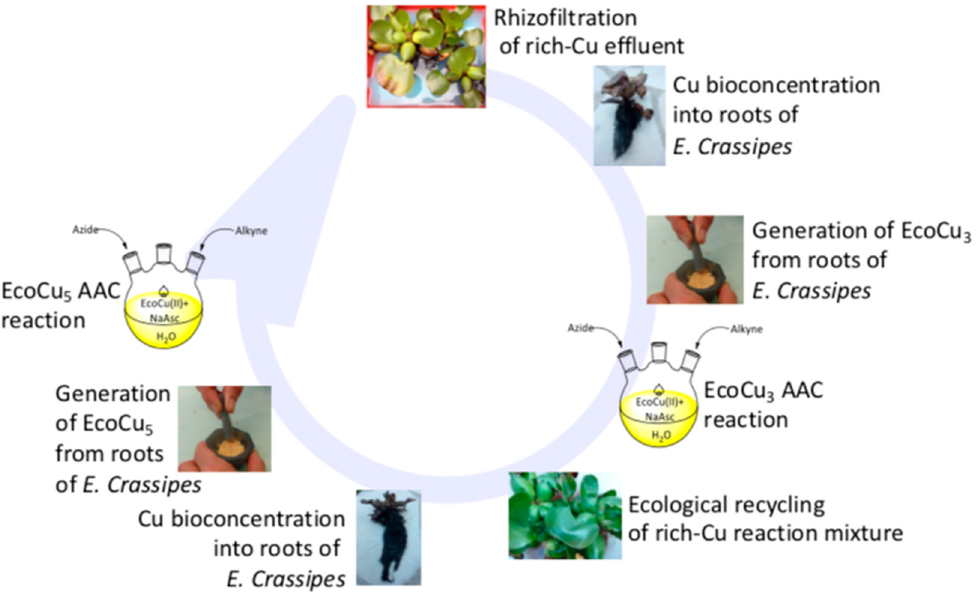
Figure 3. The recycling and reuse of the Eco-Cu 3 .